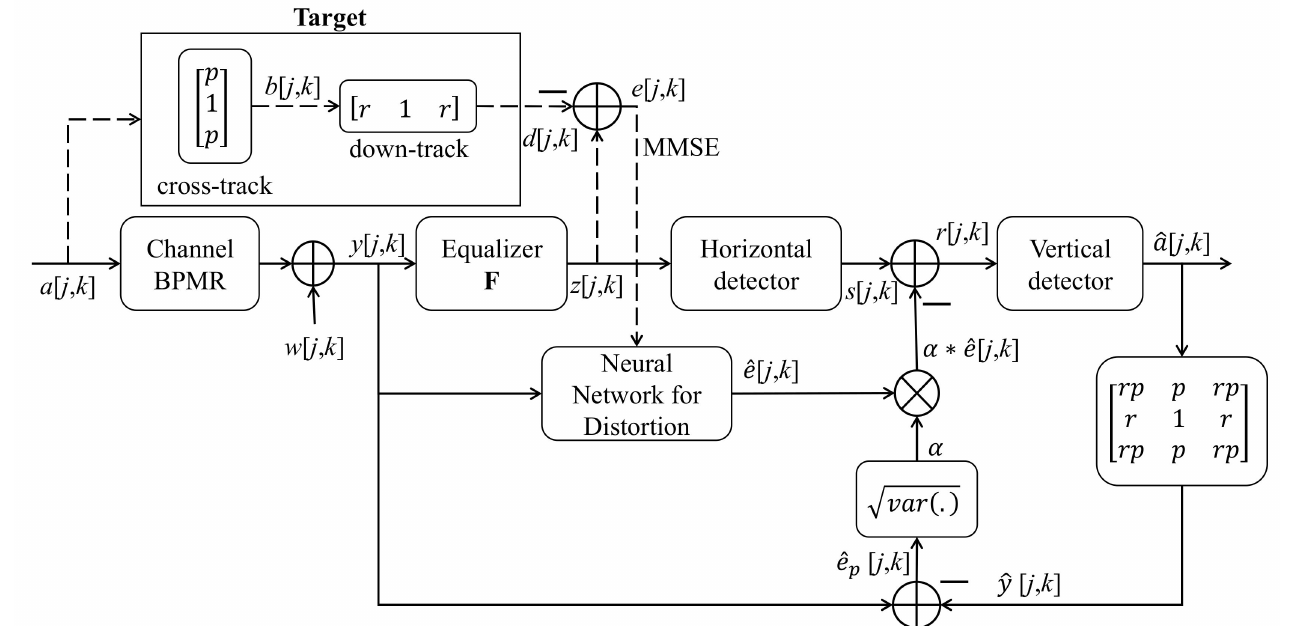
Figure 16. The estimated noise power compensation